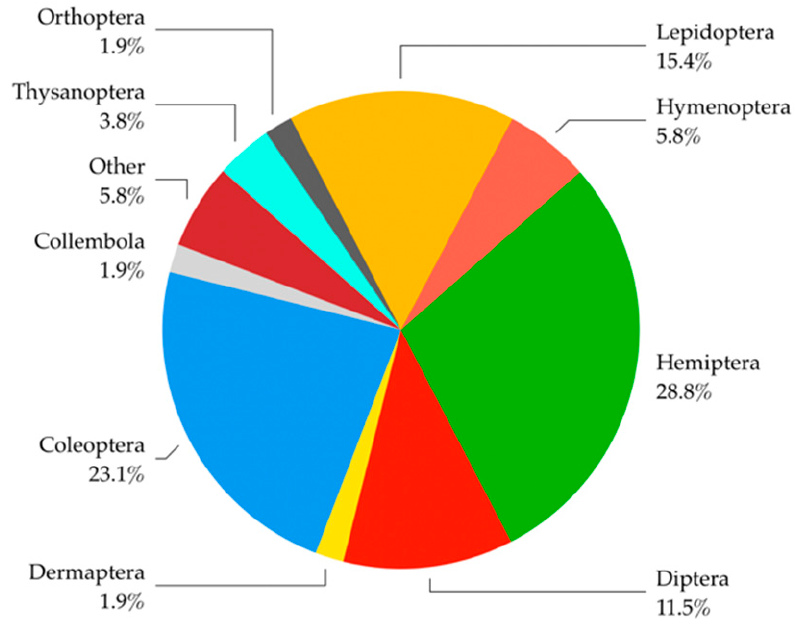
Figure 5. Relative frequency of orders to which the detected pests belong (Collembola were included due to their possible phytosanitary risk).